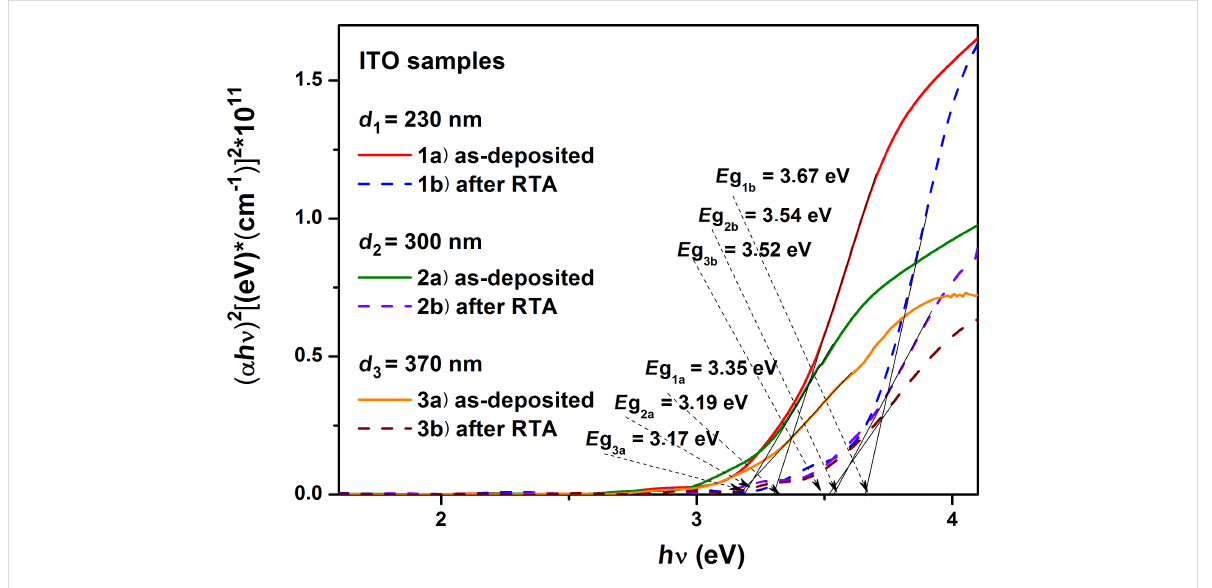
Figure 7: Dependence of ( α h ν ) 2 = f ( h ν ) on the energy of the incident photons, for the as-deposited and RTA-treated ITO samples.